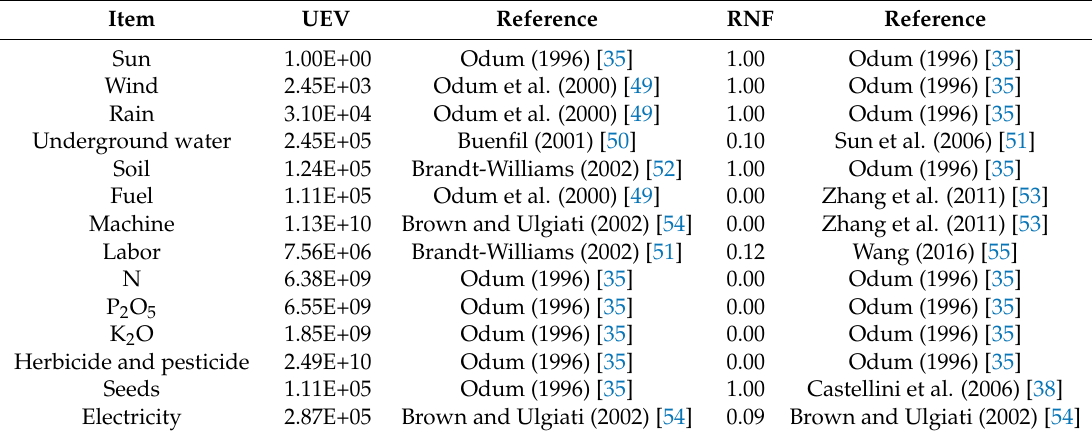
Table 2. UEV and RNF applied in this study.